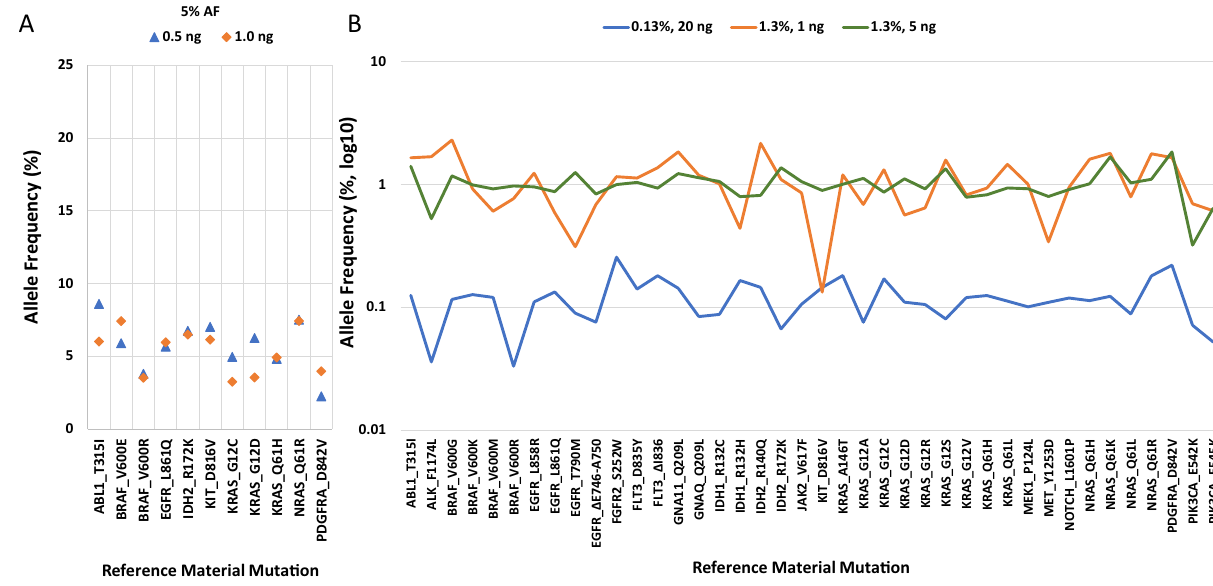
Figure 2. Technical validation of ATOM-Seq technology using reference standards. The plots show the average AF detected for each mutation in the reference material across 3 biological replicates for each of the starting DNA quantities for ( A ) 5% AF with 0.5 ng and 1 ng, for which the variance of the average allele frequency was 3.5 and 2.17 respectively, and ( B ) 1.3% AF with 1 ng and 5 ng with a variance of the average allele frequencies of 0.27 and 0.075 respectively, and 0.13% AF with 20 ng with a variance of the average allele frequencies of 0.002. The reference material contains variants with allele frequencies > 5% or > 1.3%, which were detected but not shown.